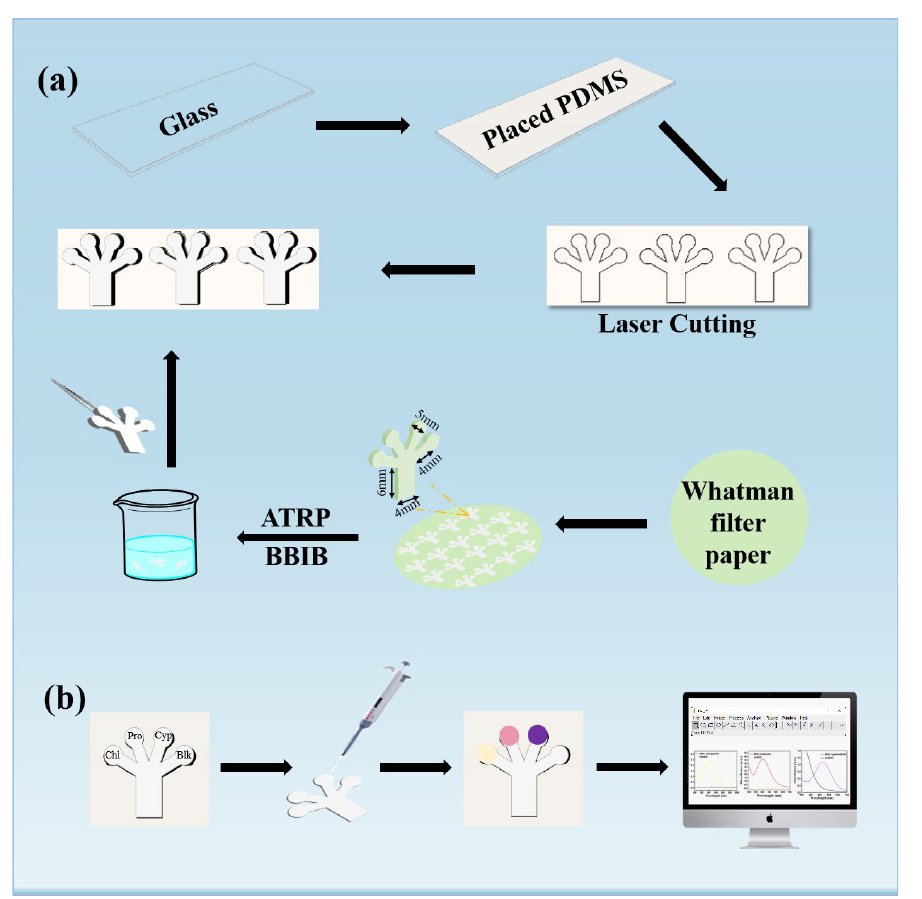
Figure 1. ( a ) The design for fabrication of pSBMA-μPAD; ( b ) process of the μPAD-based simultane- ous analysis of chlorpyrifos, profenofos and cypermethrin